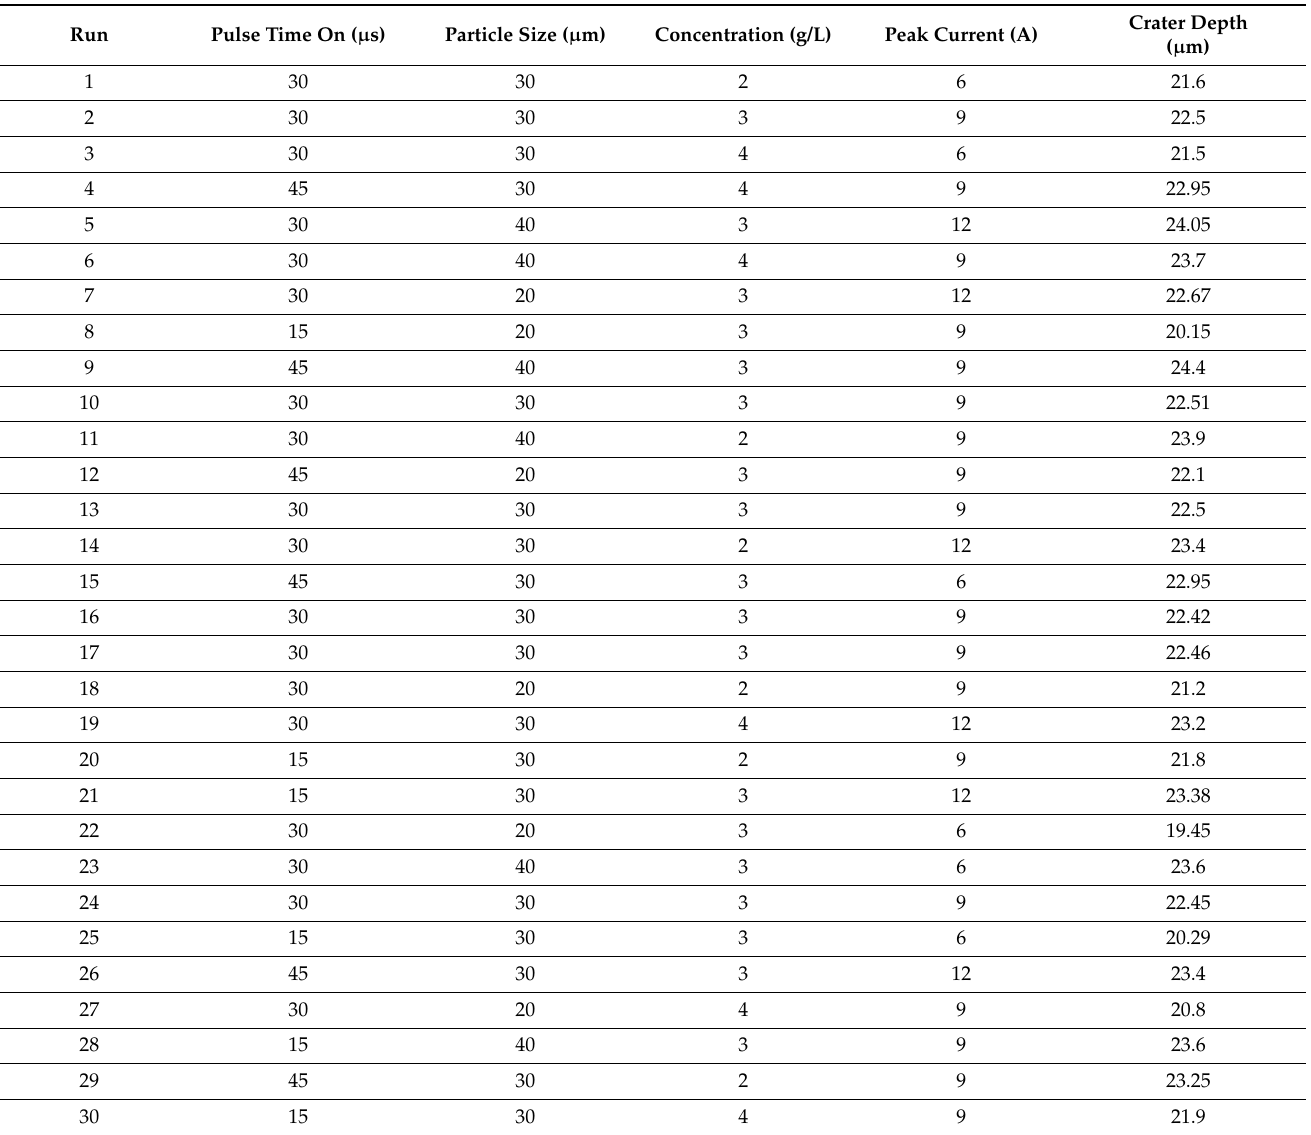
Table 10. Measurement of crater